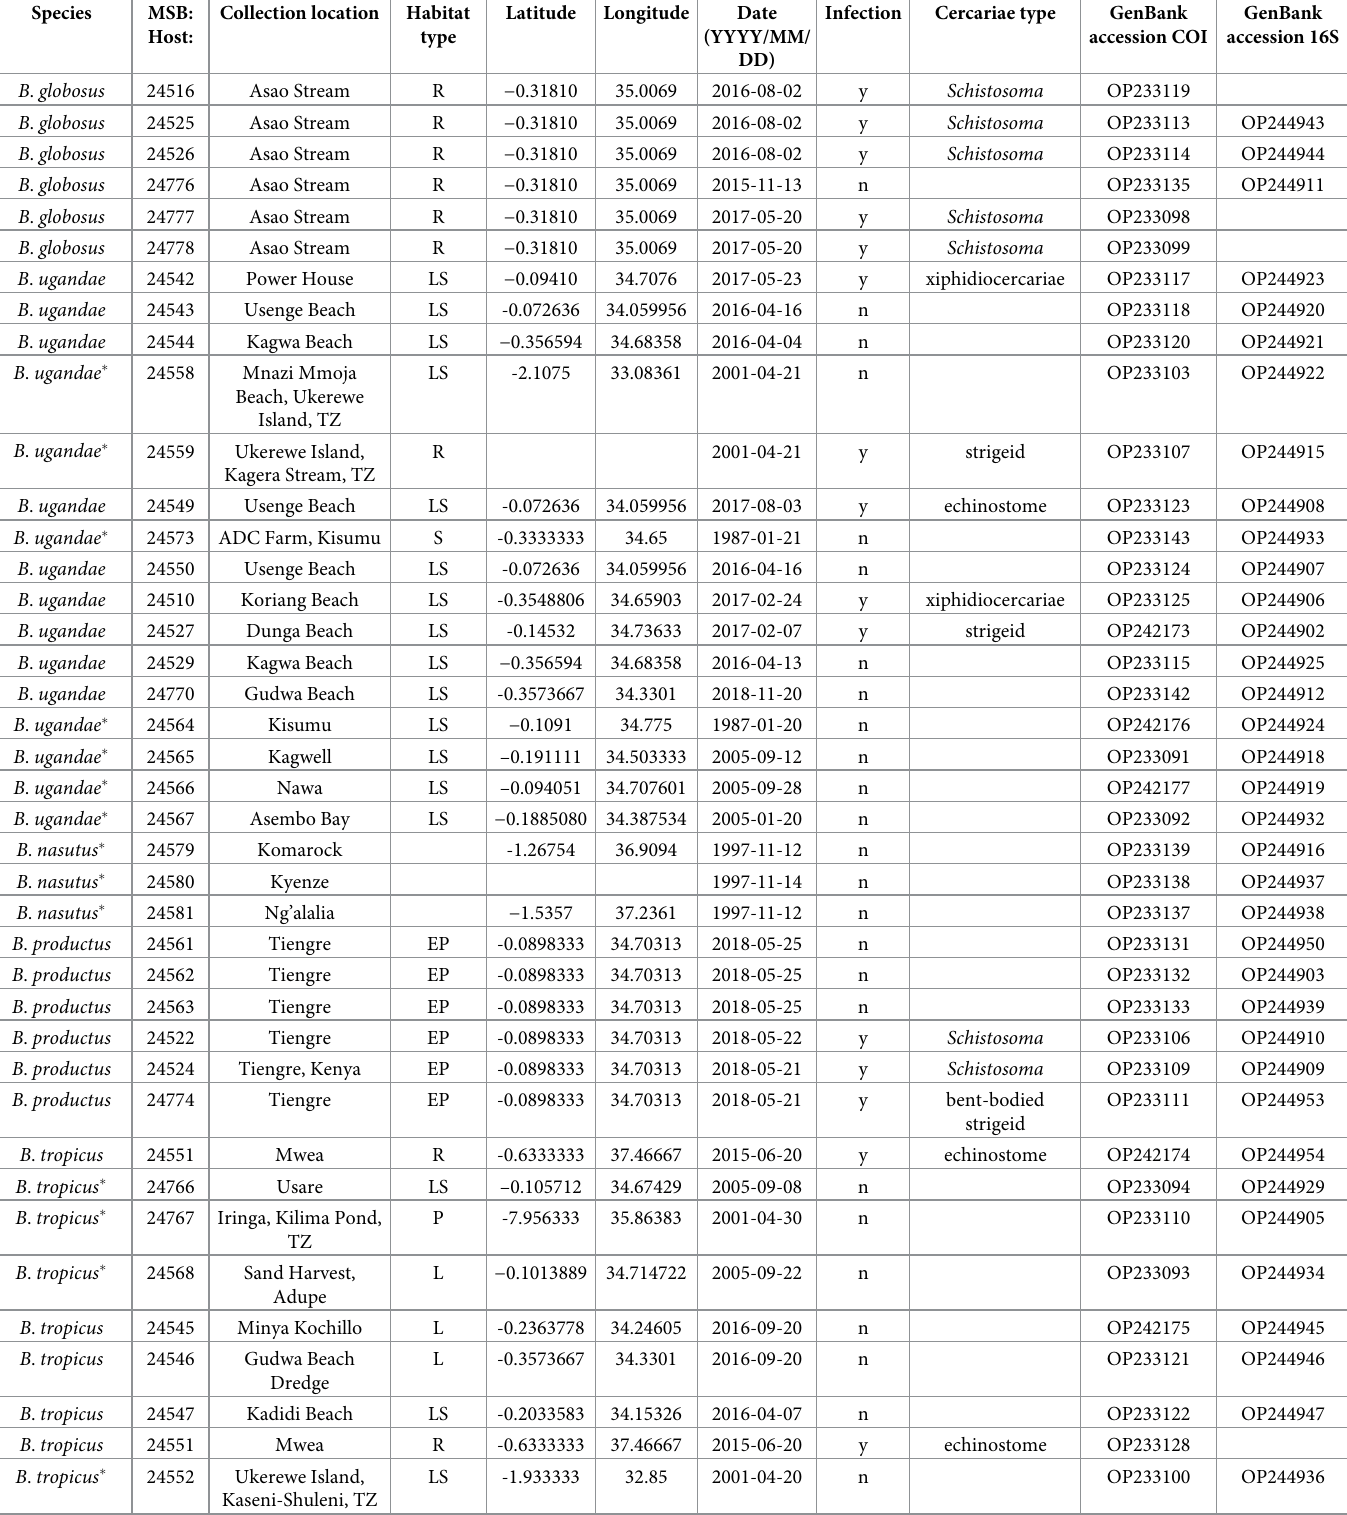
Table 1. Bulinus specimens.